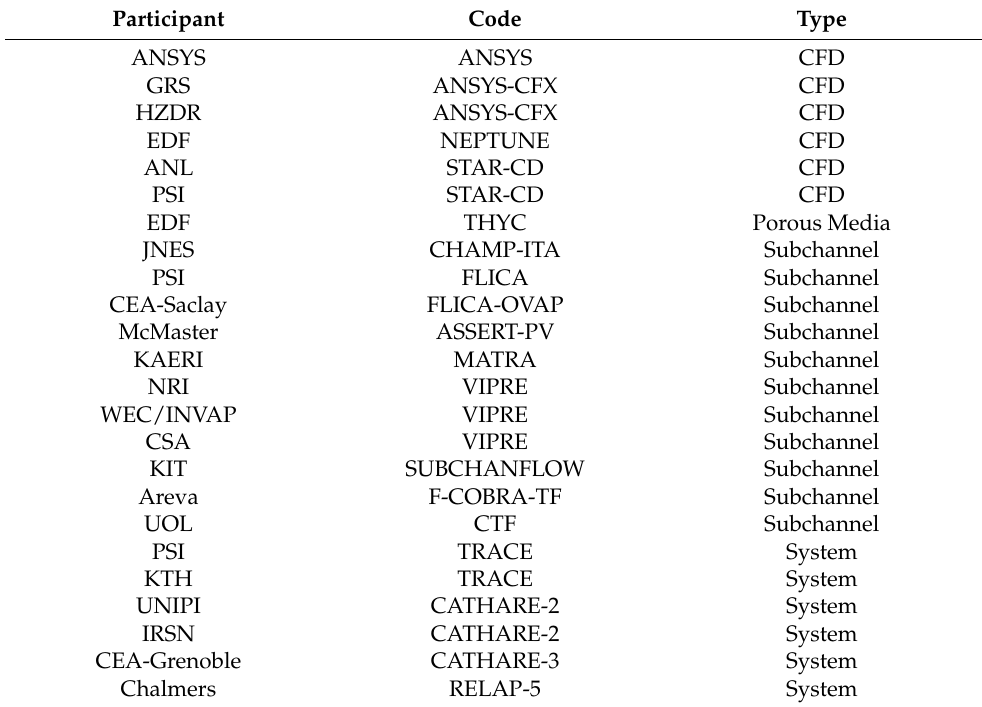
Table A1. Academic and industrial partners codes.